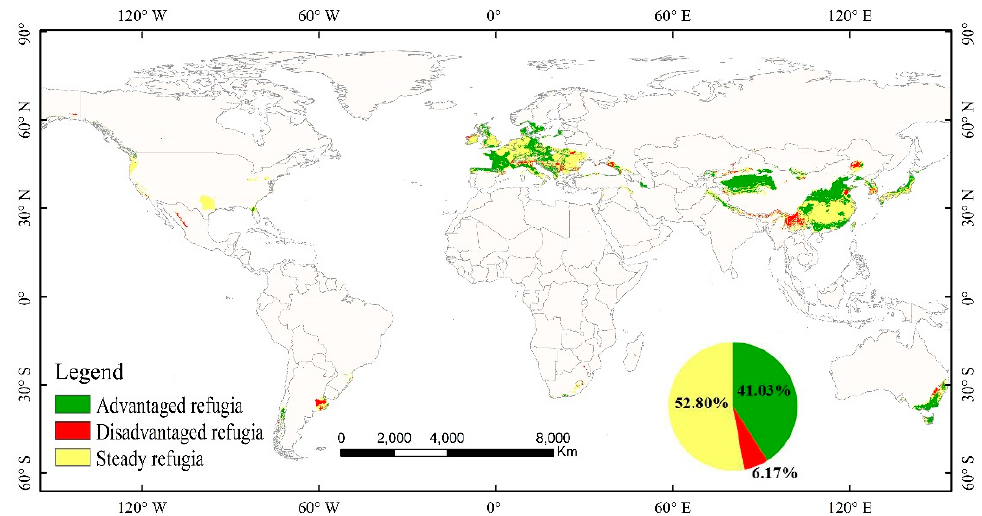
Figure 7. The location of glacial refugia of M. glyptostroboides and the changes in the refugia in future climate change.